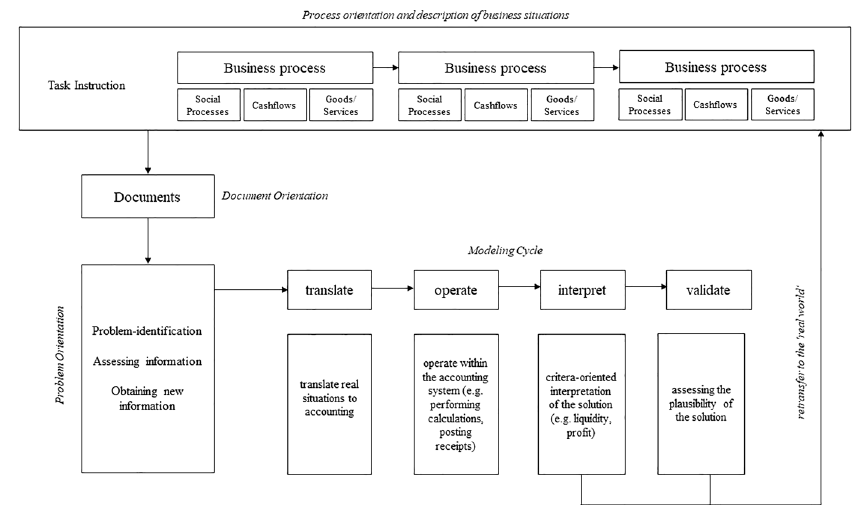
Fig. 1 Summarized characteristics for tasks in